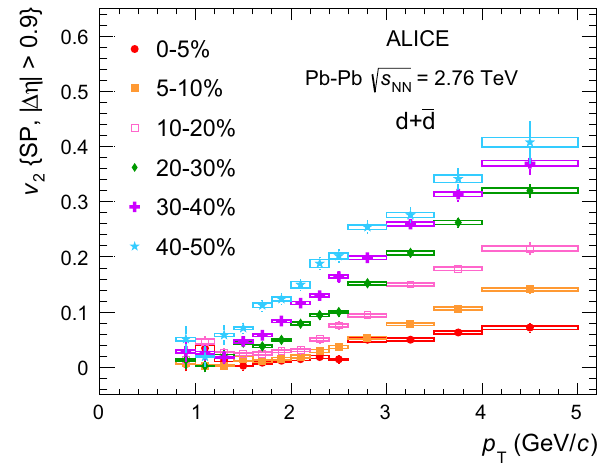
Fig. 5 Measured v 2 asafunctionof p T ford ( p T < 1.4GeV / c )andd+d ( p T ≥ 1.4 GeV / c ) for different centralityintervals in Pb–Pb collisions at √ s NN = 2.76 TeV. Vertical bars represent statistical errors, while boxes are systematic uncertainties